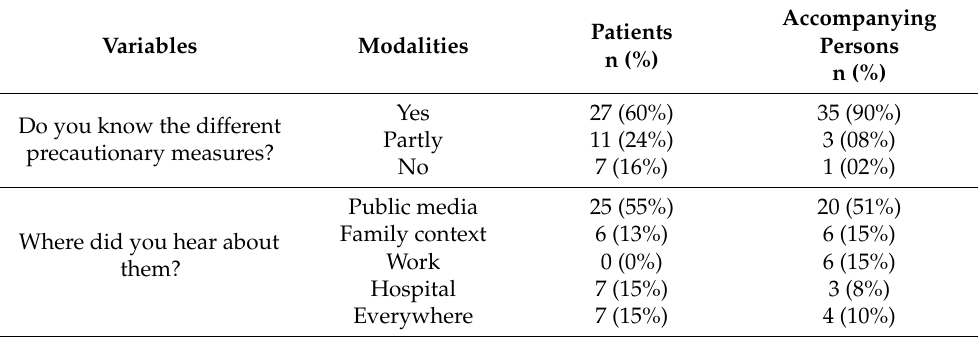
Table 4. Participants’ (patients and accompanying persons) results on self-rated knowledge of COVID-19 precautionary